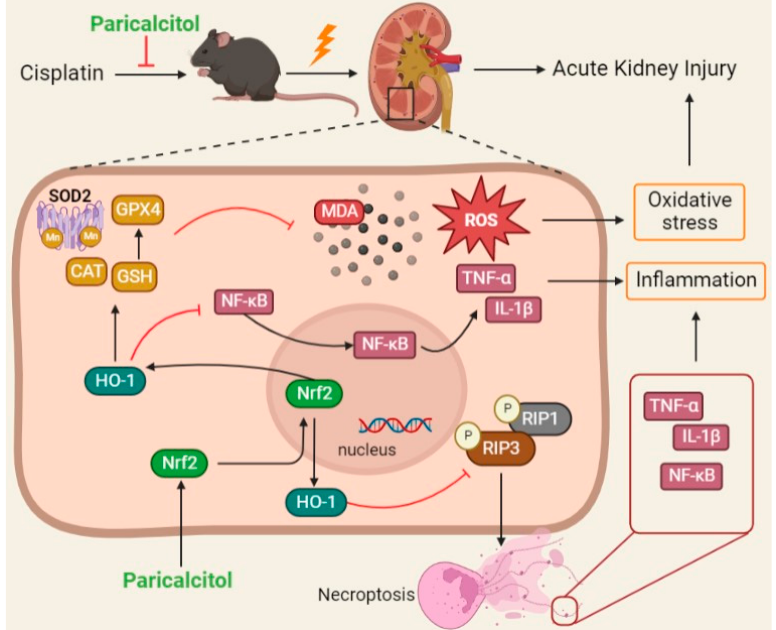
Figure 8. The schematic diagram of paricalcitol upregulating Nrf2/HO-1 signaling to improve cisplatin-induced kidney injury. Cisplatin induces oxidative stress and inflammation by promoting the accumulation of oxidative products (ROS and MDA) and the secretion of inflammatory factors (IL-1 β , TNF- α and NF- κ B). Paricalcitol plays a protective role in the kidney by enhancing renal anti-oxidant and anti-inflammatory levels via Nrf2/HO-1 signaling.